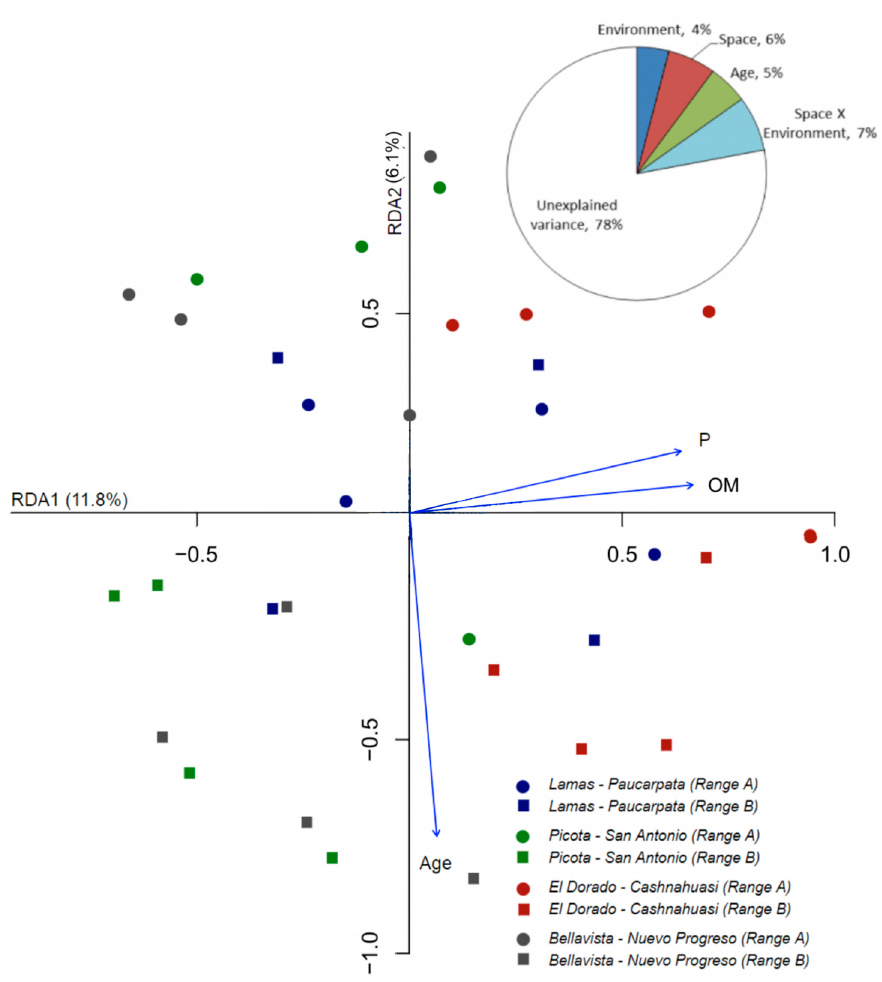
Figure 4. Ordination of the arbuscular mycorrhizal fungi community composition via redundancy analysis (RDA) (TRFLP peak profile approach) in four localities in the San Martín region. The pie chart shows a variance partition of the community composition explained by environmental factors (soil organic matter -OM- and P), plot spatial position, and crop age. In the figure, age, soil OM, and soil P content were used as constraints.